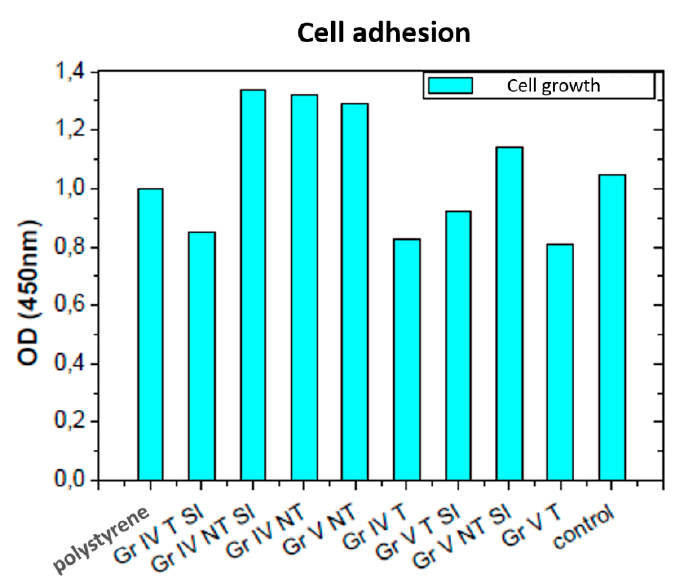
Table 12. Absorbance and number of cells arising from the result on the samples studied in cell culture.